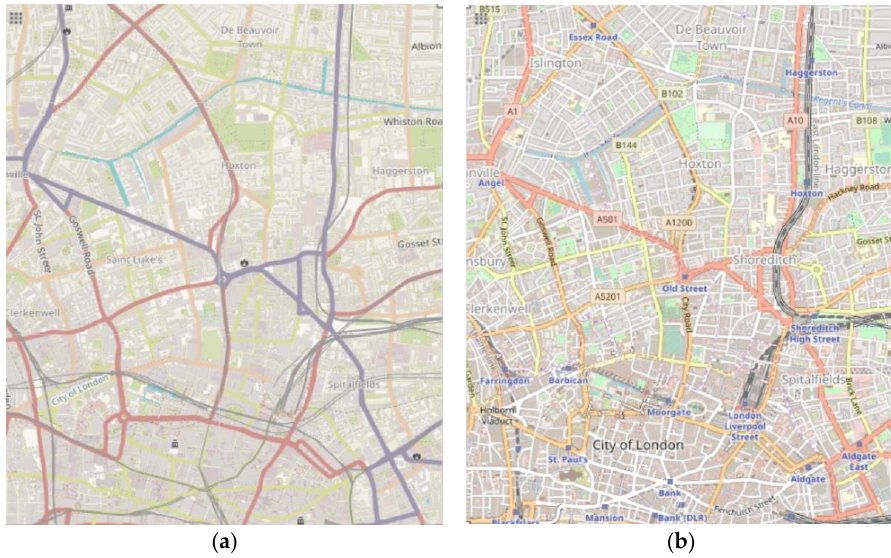
Figure 4. The simulated map: ( a ) transportation view ( b ) full view.